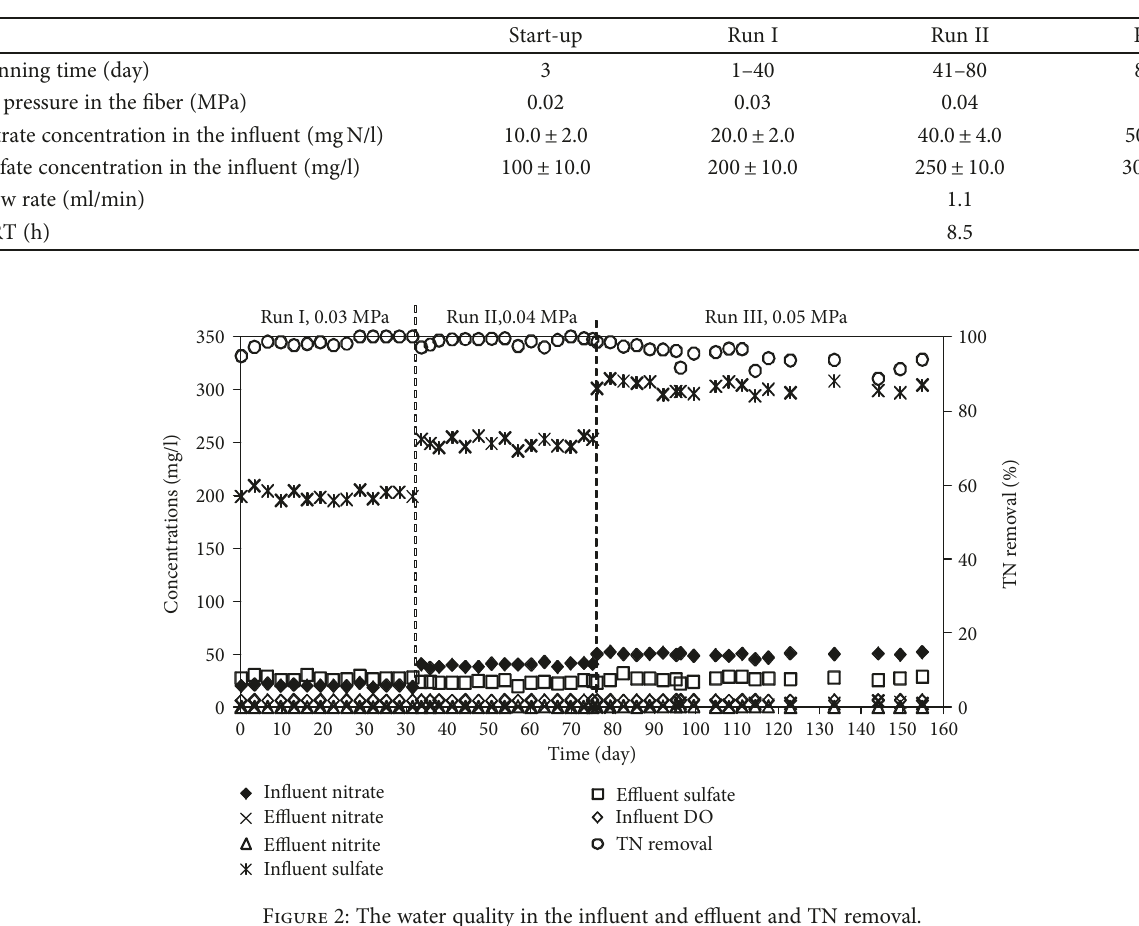
Table 3: Experimental design of the reactor running.